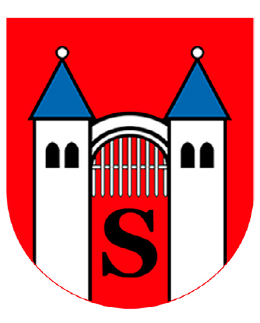
Figure 19. The former arms of